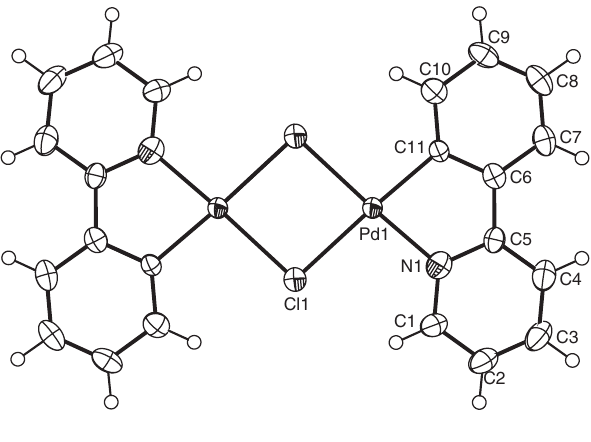
Table 2: Atomic coordinates and isotropic displacement